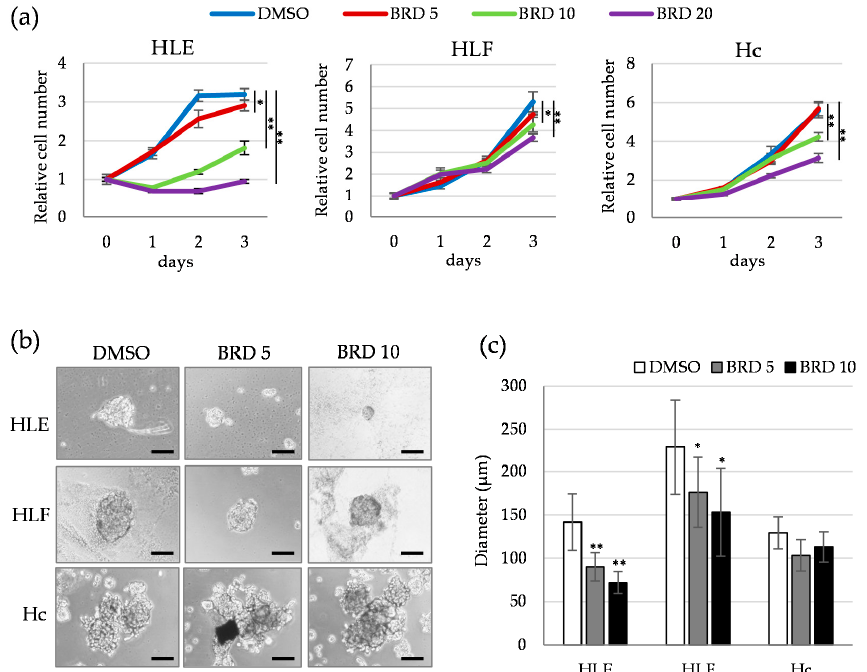
Figure 4. Small molecule-mediated inhibition of HDAC9 decreased the cell growth of monolayer- and 3D-cultured HCC cells. ( a ) Cell proliferation assays of HLE ( left ), HLF ( center ), and Hc ( right ) cells treated with dimethyl sulfoxide (DMSO) (vehicle control) and BRD4354 (5, 10, and 20 µ M) for 3 days. Cell viability was determined by WST assay and expressed as the relative amount of viable cells compared to day 0. * p < 0.05, ** p < 0.01 vs. DMSO group. ( b ) Morphological appearance of spheres formed in the culture medium containing DMSO and BRD4354 (5 and 10 µ M). Cells were cultured in an ultra-low attachment culture plate for 7 days and photographed. Scale bar = 200 µ m. ( c ) The diameter of the sphere was measured in ten representative spheres of each group. * p < 0.05, ** p < 0.01